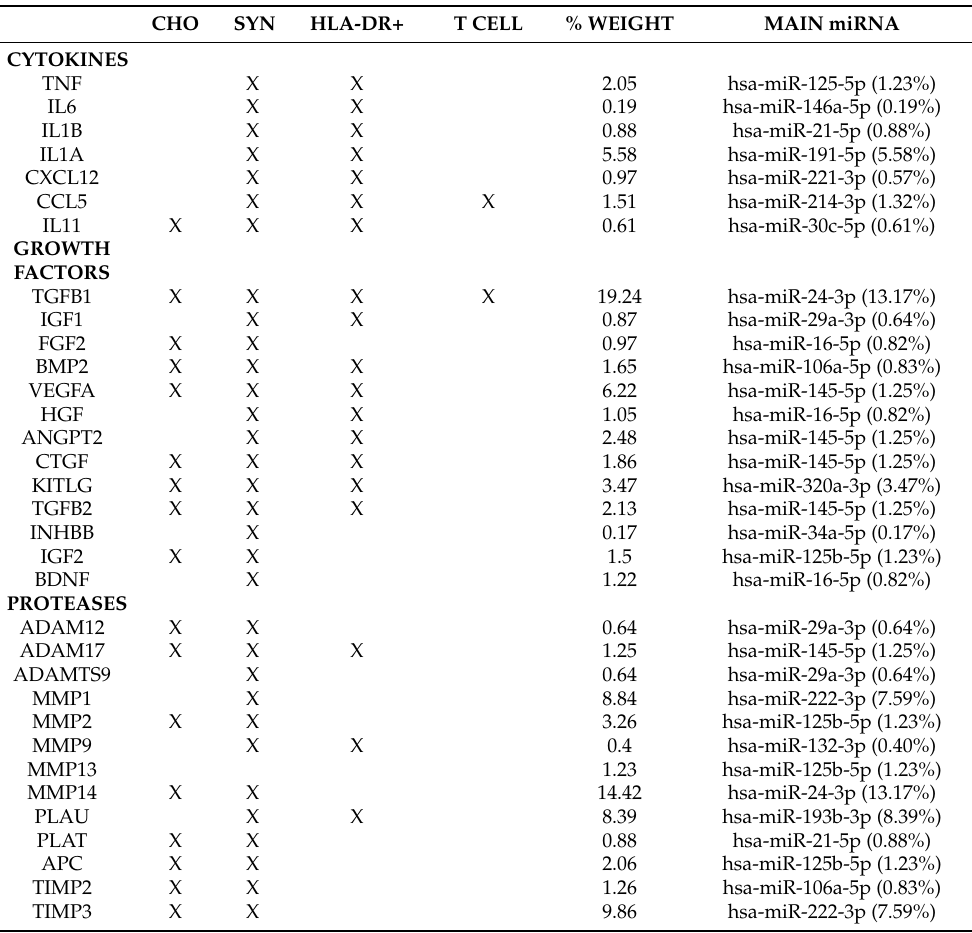
Table 4. OA regulators expressed by at least 1% of indicated cell types and targeted by first quartile EV-miRNAs.